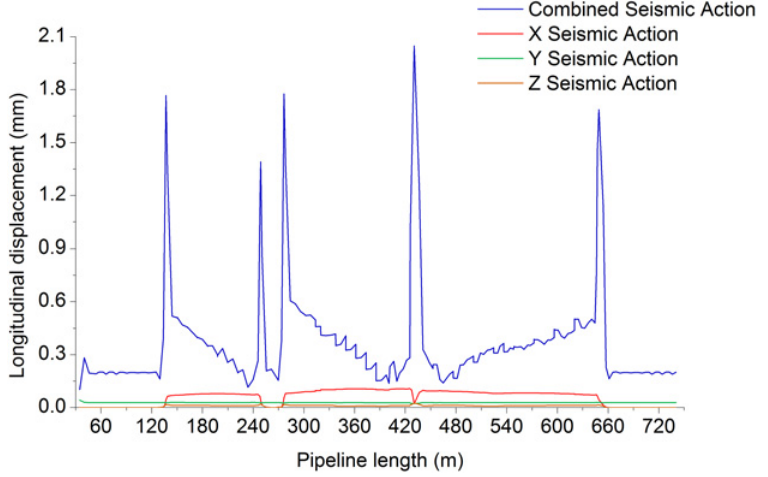
Fig 8. Pipeline longitudinal displacement during seismic